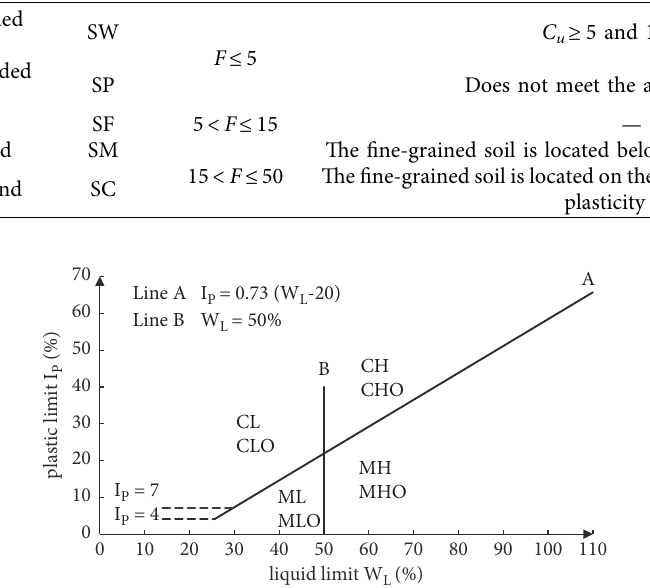
Figure 1: The plasticity chart. Low liquid limit (L): W